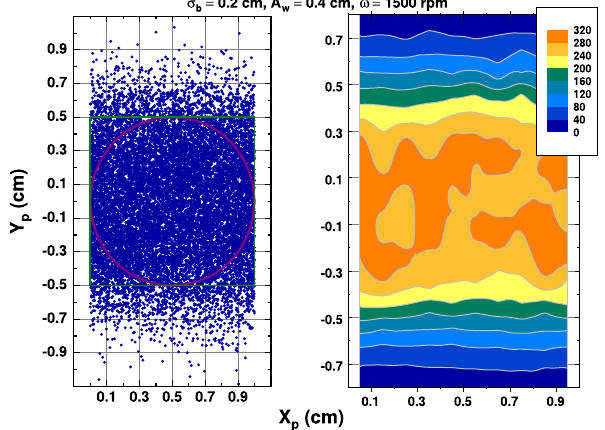
FIG. 13. The result of 3 × 10 4 MC simulations for beam width σ 0 . 2 cm and wobbling amplitude on the target surface b ¼ A 0 . 4 cm is shown for the rotating target with central radius w ¼ R 12 cm and rotating velocity ω ¼ 1500 rpm (left panel). The c ¼ same distribution reduced to the number of events collected by the 0 . 1 × 0 . 1 cm cell and subsequently smoothed is shown in the right panel as a contour map. Frames corresponding to the circular and square diaphragm of respective sizes are shown in the left panel.